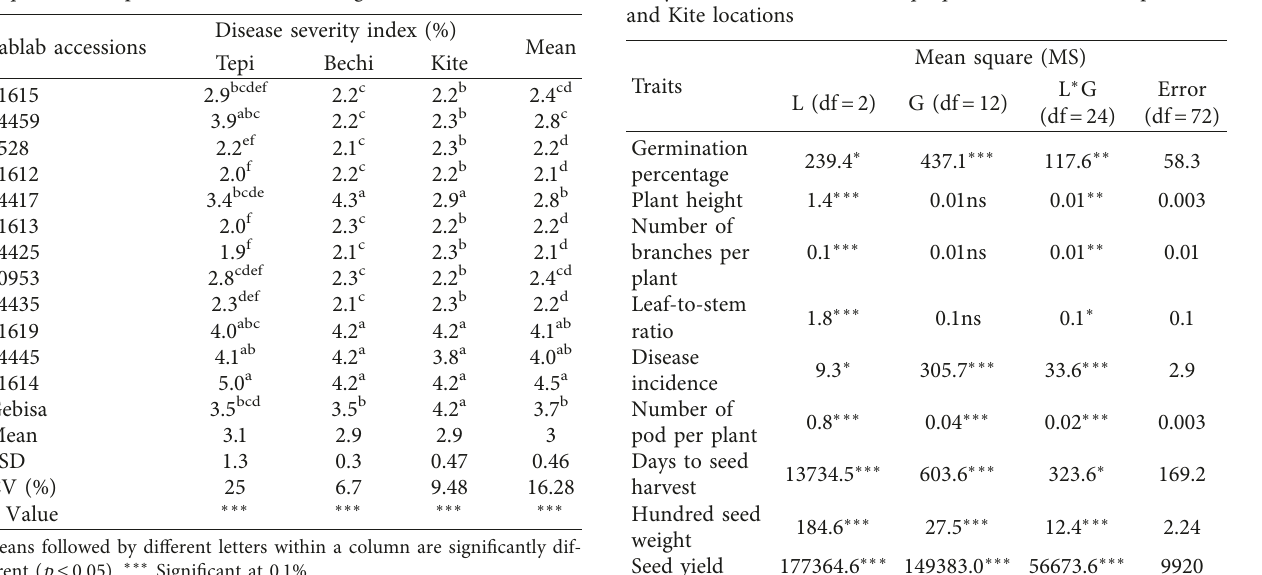
Table 9: Disease severity index of different accessions of Lablab purpureus at Tepi, Bechi, and Kite testing sites.